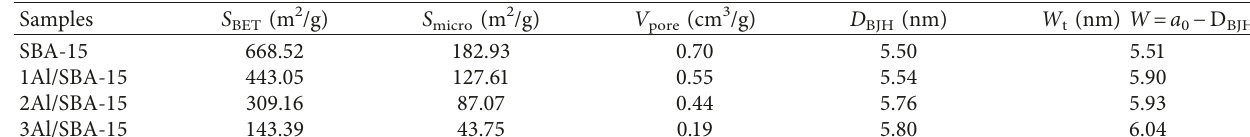
Figure 2: BET specific surface area of SBA-15 and xAl/SBA-15 samples (a) and pore size distribution Table 2: Textual characteristics of SBA-15 and xAl/SBA-15 samples.